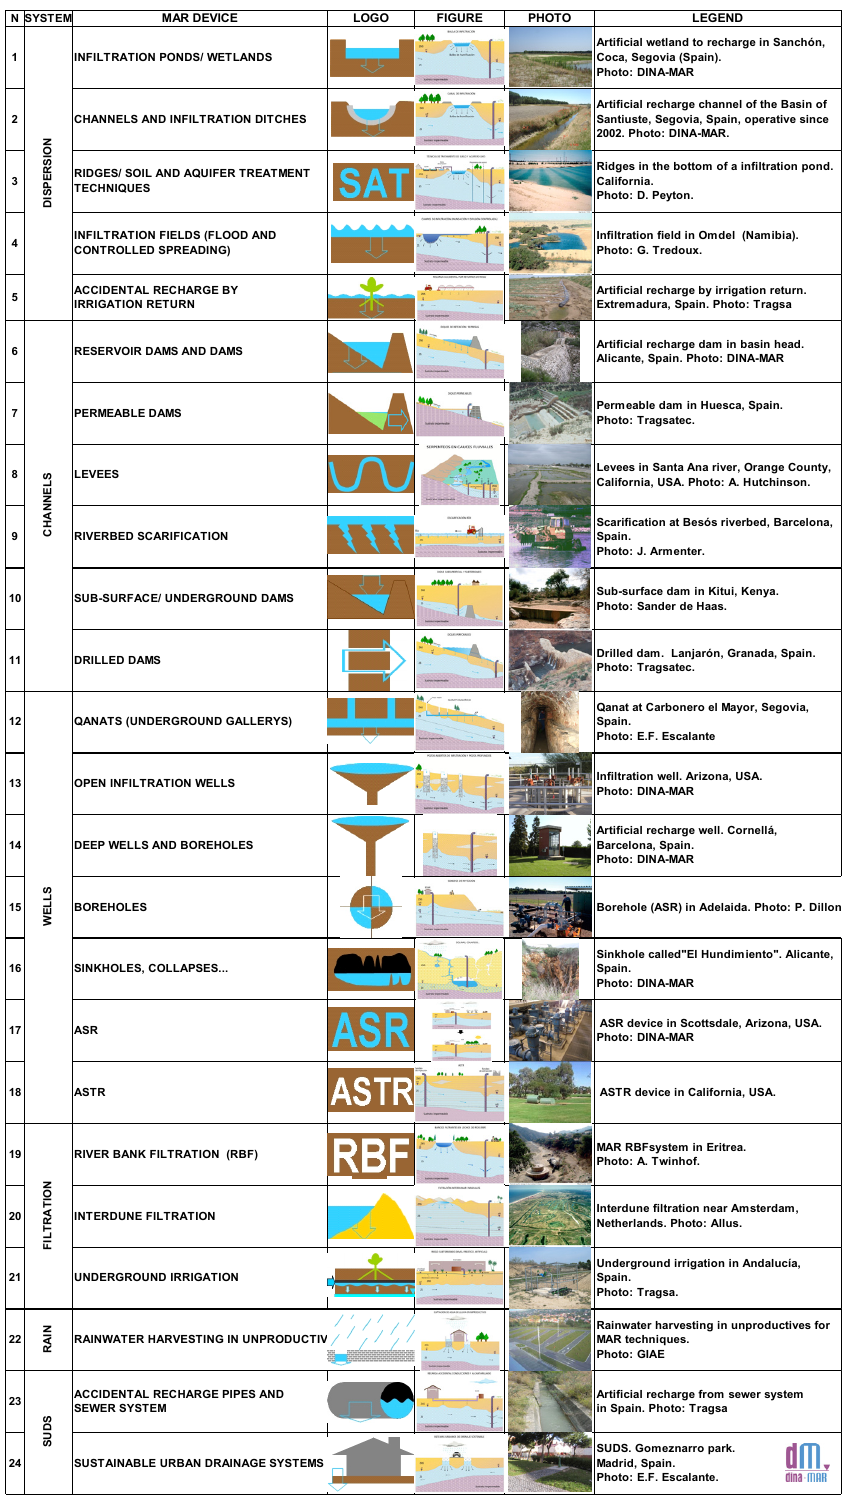
LOGO FIGURE PHOTO LEGEND Artificial wetland to recharge in Sanchón, Coca, Segovia (Spain). Photo: DINA-MAR Artificial recharge channel of the Basin of Santiuste, Segovia, Spain, operative since 2002. Photo: DINA-MAR. Ridges in the bottom of a infiltration pond. California. Photo: D.